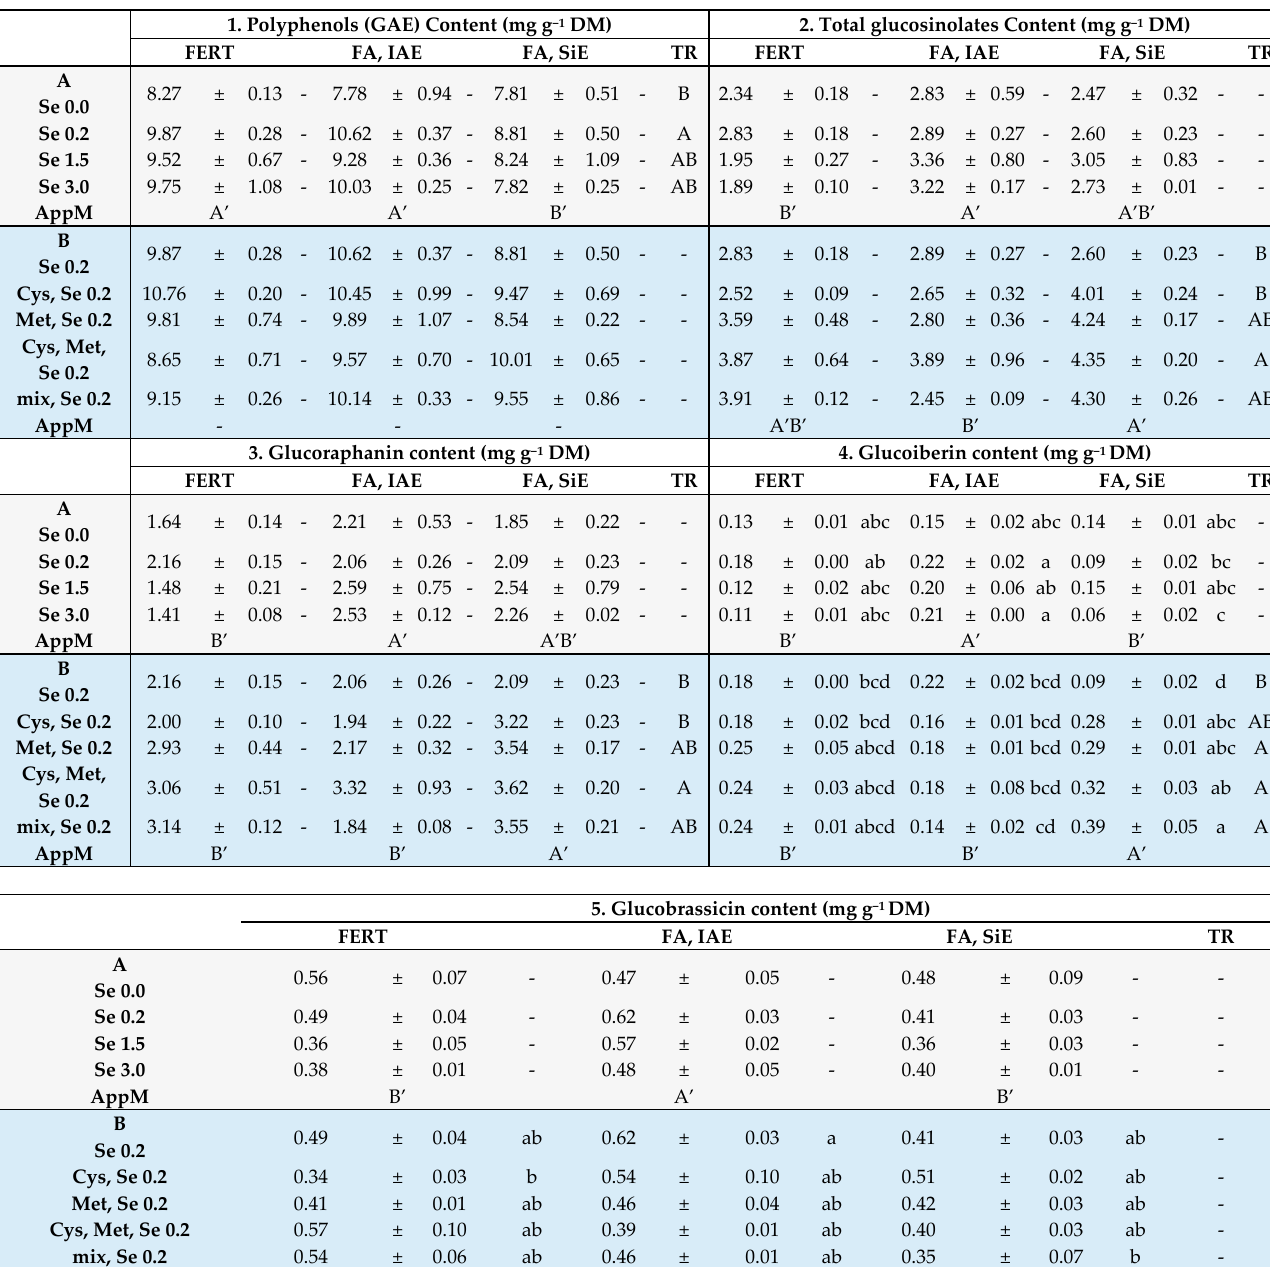
Table 3. The performance of the gradient of selenium concentration (A) or the combination of sele- nium 0.2 mM with amino acids (B) and application mode on the biofortification of florets. Means +/ − SE are provided for (1) polyphenols, (2) total glucosinolates, (3) glucoraphanine, (4) glucoiberin, and (5) glucobrassicin contents. Different letters indicate statistically significant differences in Tukey–Kramer test at p ≤ 0.05. TR : statistical evaluation among treatments. AppM : statistical evaluation among application modes. Dash indicates that the two-way ANOVA did not reveal any differences at the p < 0.05 level. In the A group, control treatment served the fertigation without Se application (Se0.0/FERT). In the B group as control treatment served the fertigation with Se 0.2 mM (Se0.2/FERT).